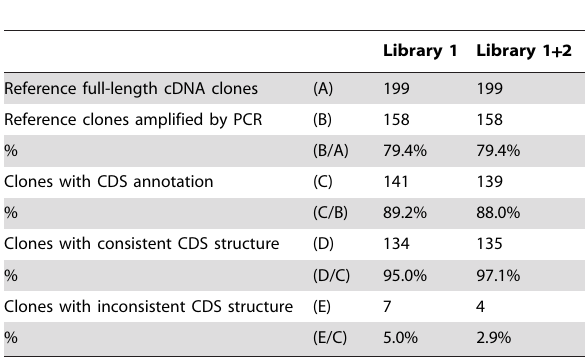
Table 2 compared the output cDNA sequences and the reference cDNAs in terms of the consistency of the CDS structure, which was obtained by alignment against the reference genome. Of all clones with CDS annotation and successful PCR amplification, the reference CDS structure was completely contained in the reconstructed exon-intron structure Table 2. Assembly statistics and accuracy evaluation for human full-length cDNA